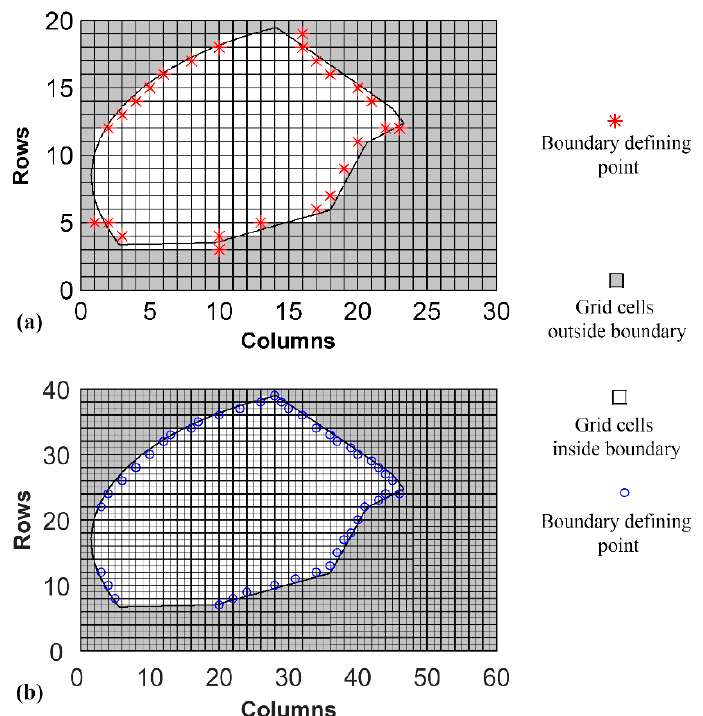
Figure 2. Schematic of the boundary handling technique for the optimization study using the grid method with: ( a ) coarse 20 × 30 grid and ( b ) refined 40 × 60 grid.